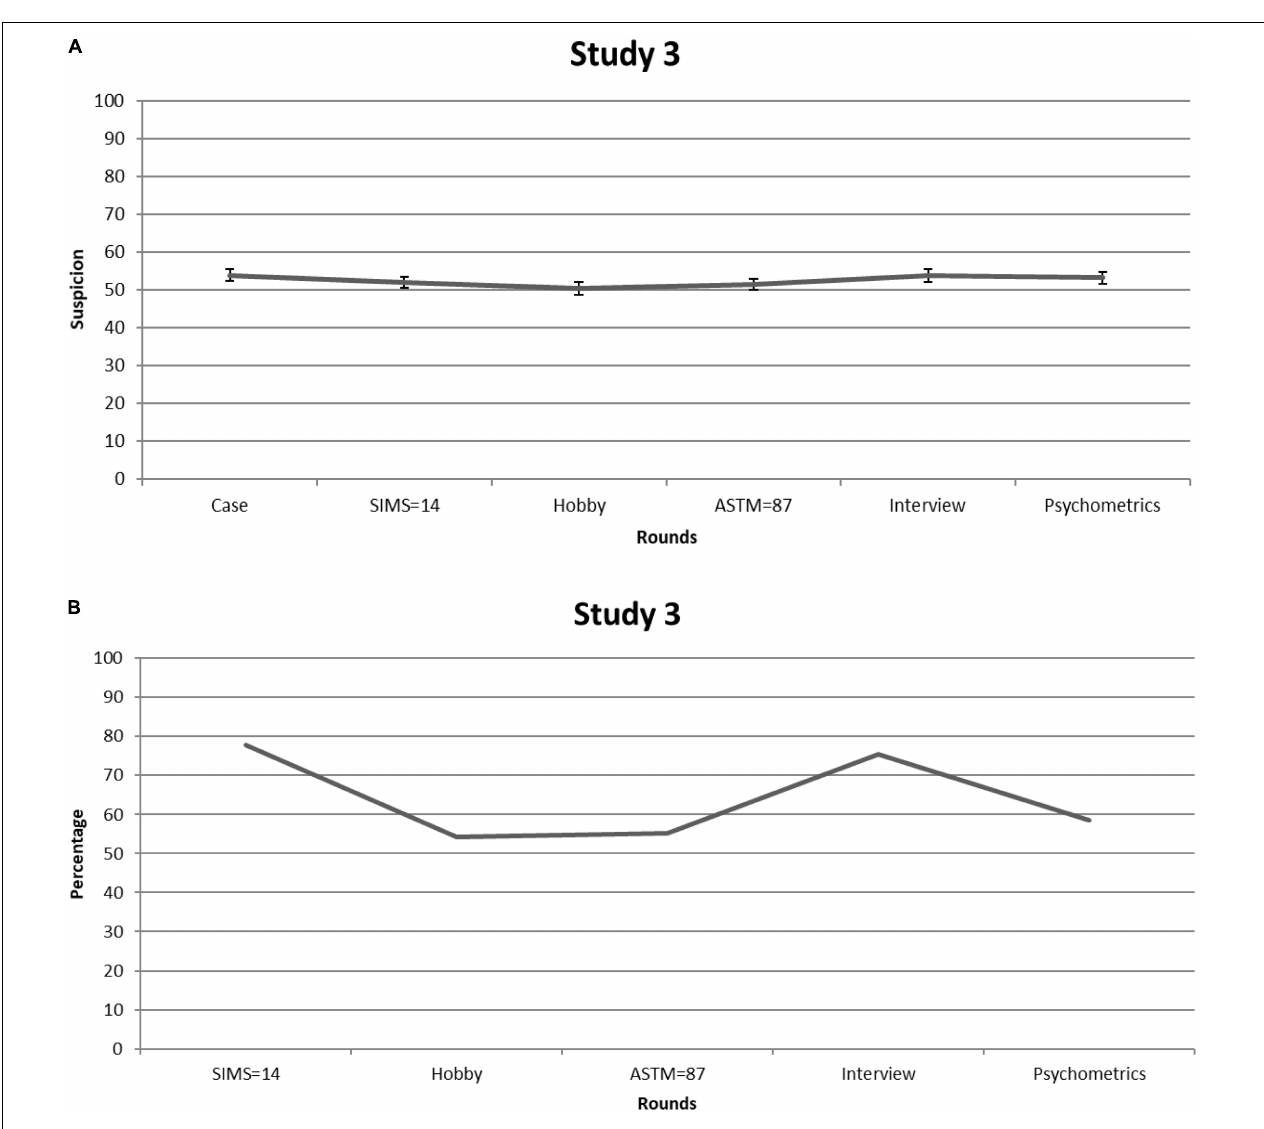
FIGURE 3 | Study 3. (A) Clinical experts’ mean feigning x confidence ratings after each round. Error bars are Standard Errors of the Mean. (B) Percentages of clinical experts who (per round) considered mentioning (possible) feigning as a conclusion in their reports.